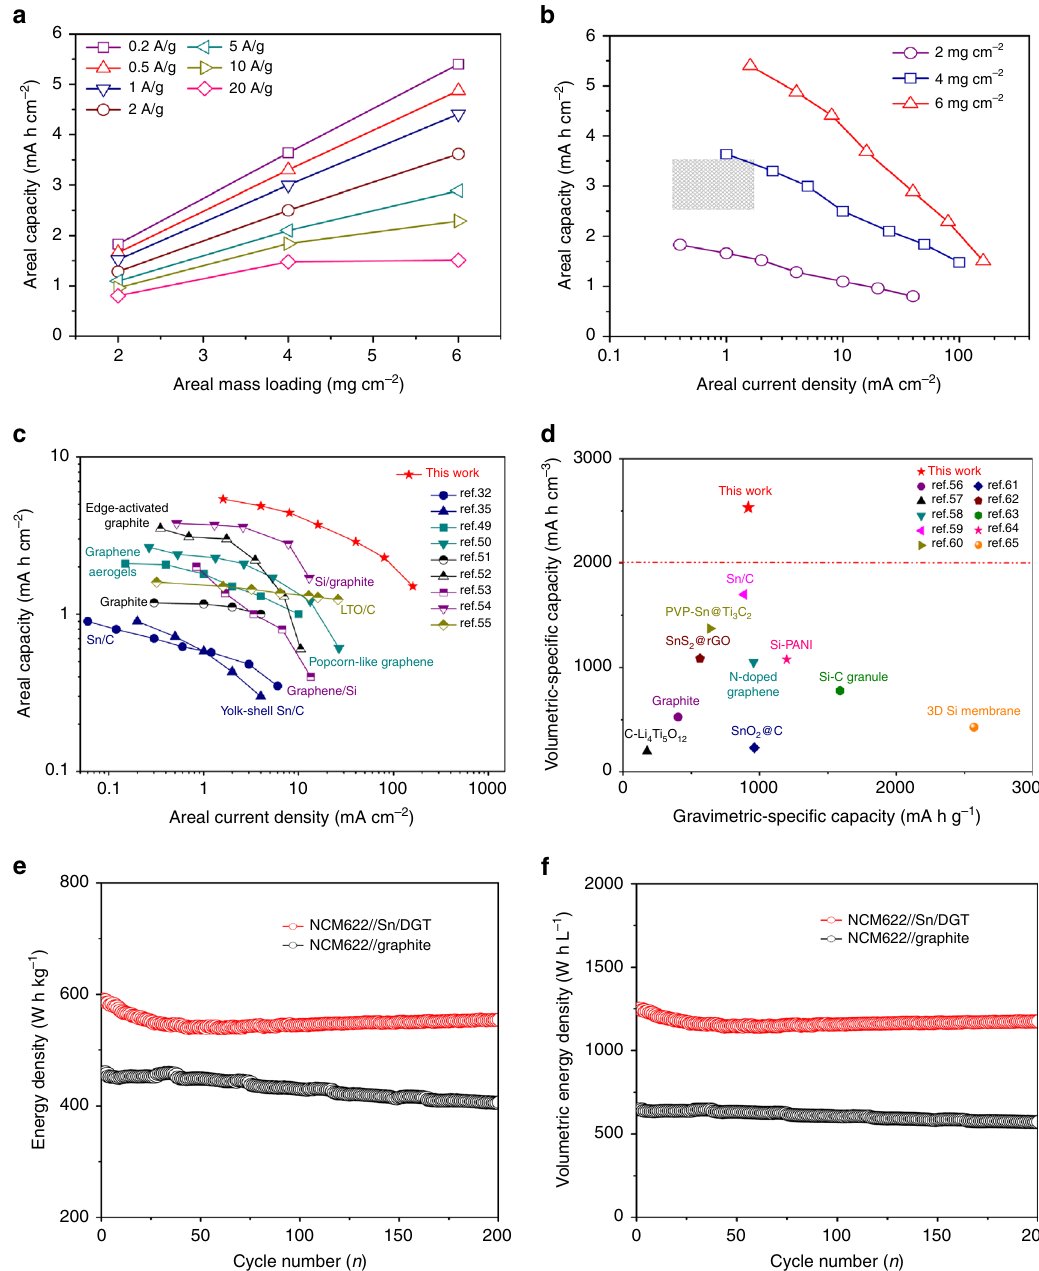
Fig. 6 Feasibility of adapting Sn/DGT as high-performance anodes for commercial batteries. a The areal capacity of Sn/DGT electrodes with mass loading of 2, 4, and 6 mg cm − 2 at different charge-discharge current densities. b The areal capacity of Sn/DGT electrodes vs. the areal current density of the Sn/DGT anodes with a mass loading of 2, 4, and 6 mg cm − 2 , respectively. The gray area marked represents the range of areal capacity of commercial graphite anodes. c A comparison of the areal performance metrics of Sn/DGT electrode (mass loadings of 6 mg cm − 2 ) with representative anodes reported, including the anodes from graphite, graphene, Li 4 Ti 5 O 12 (LTO), Sn/C and Si/C. d A comparison of the speci fi c volumetric capacity of Sn/DGT electrode (active materials only) with reported anode materials, including the anodes of graphite, LTO, Sn/C, and Si/C. e The gravimetric and f volumetric energy density of a cell consisting with a NCM622 cathode and a Sn/DGT anode, as well as a cell consisting with a NCM622 cathode and graphite